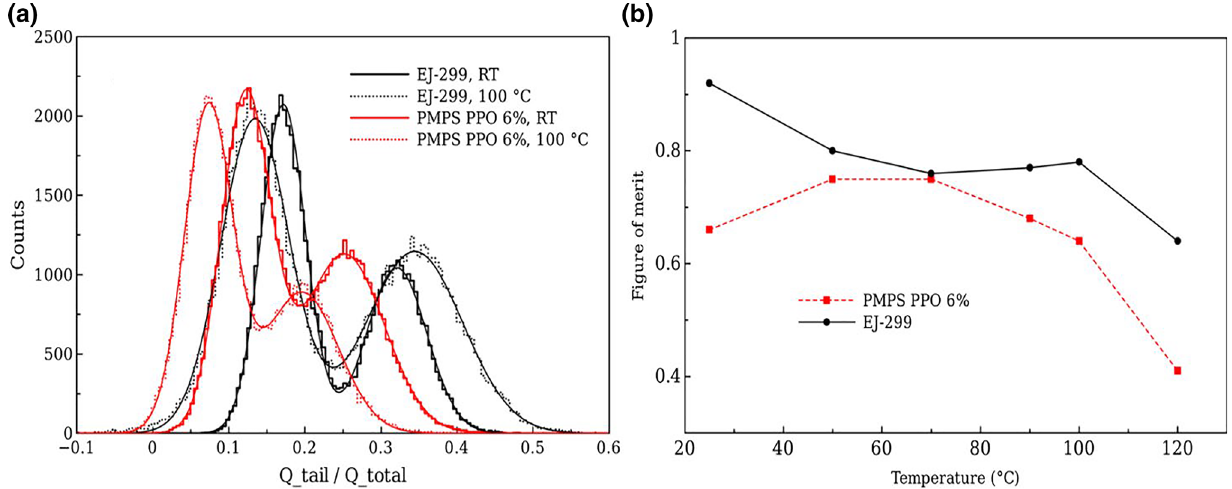
Fig. 8 a Q tail / Q total histograms corresponding to the EJ-299 and to the PMPS scintillators, at room temperature and 100 ◦ C. Only events with light output in the range (480 ± 75) keVee were included. Gaussian